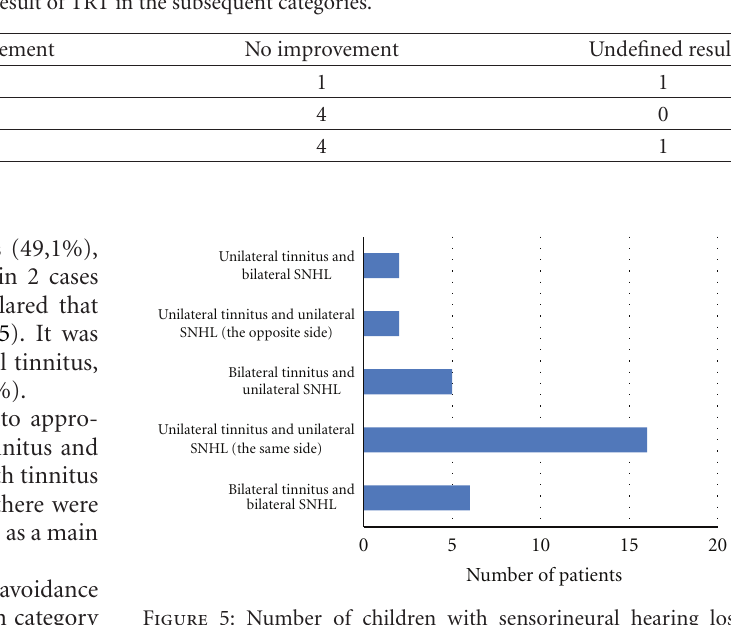
Figure 5: Number of children with sensorineural hearing loss (SNHL) divided into 5 groups according to laterality of tinnitus and